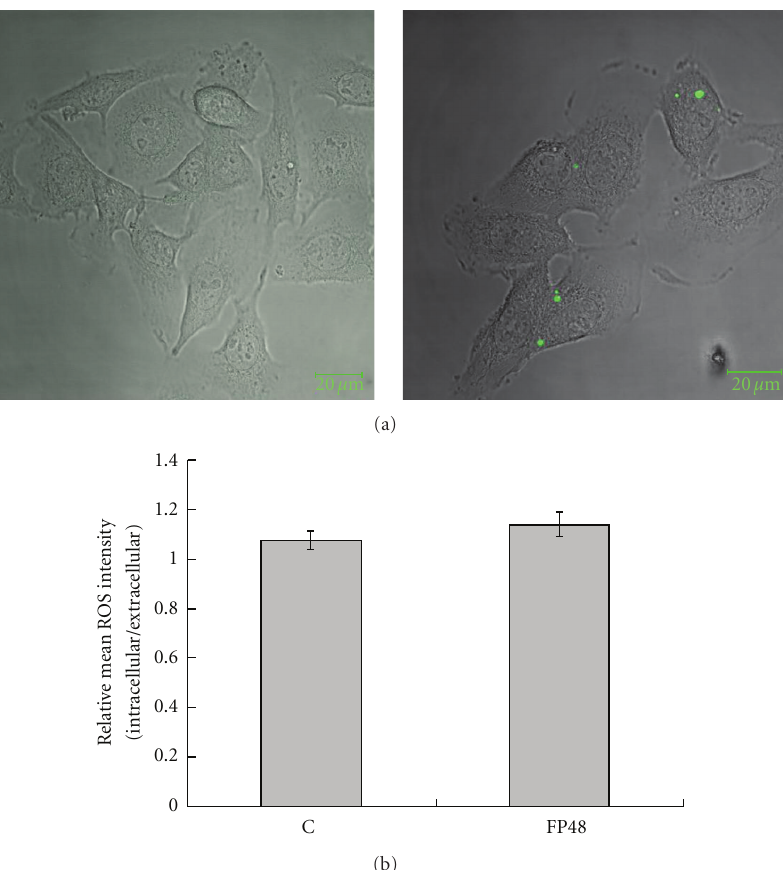
Figure 6: Intracellular ROS by confocal laser scanning microscopy. (a) Stained images of ROS in the control group (left) and cFIR group (right). Scale bars = 20 μ m. (b) Comparison of normalized mean ROS fluorescence intensity in B16-F10 cells between the control (group C) and cFIR (group FP48) groups.